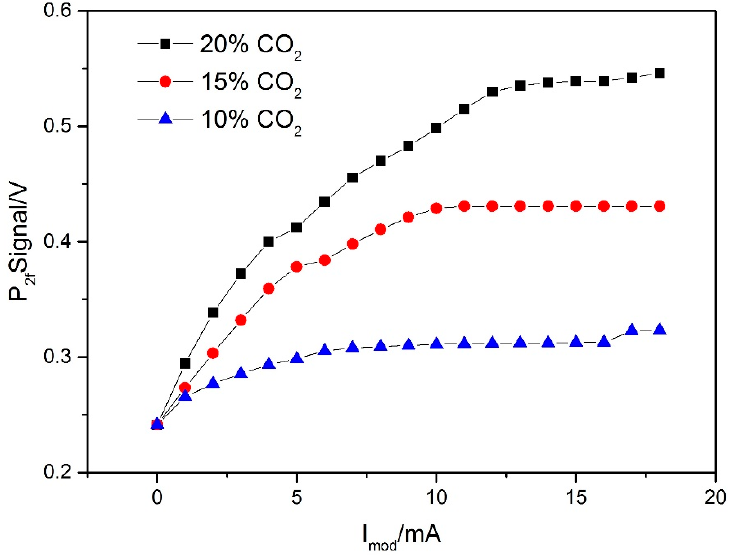
Figure 11. WMS (Wavelength modulation spectroscopy)-2f peak signals as a function of the laser modulation current I mod at different concentrations of CO 2.